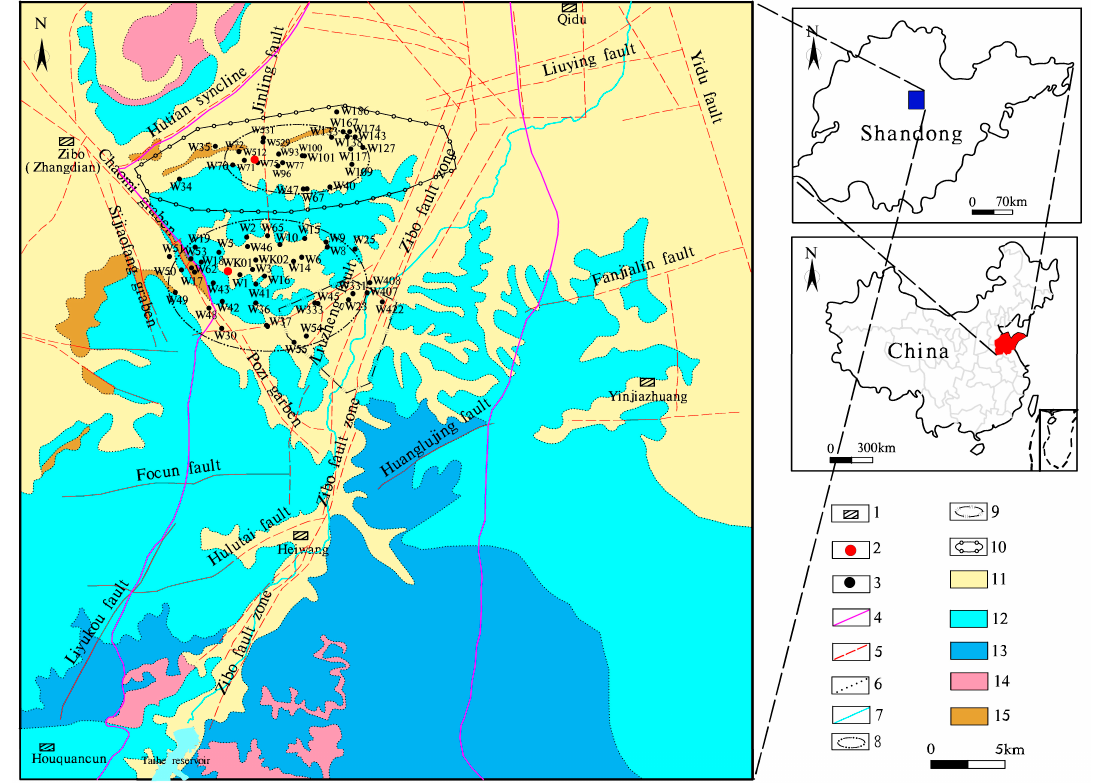
Figure 1. Geology of the study area. 1: Village; 2: Source well; 3: Observation well; 4: Simulation zone boundary; 5: Fault; 6: Geological boundary; 7: River; 8: Tracer test area; 9: Dawu water source exploitation area; 10: Liuzheng water source exploitation area; 11: Quaternary loose layer; 12: Ordovician limestone; 13: Cambrian limestone; 14: Magmatic rock; 15: Carboniferous-Permian sand shale.